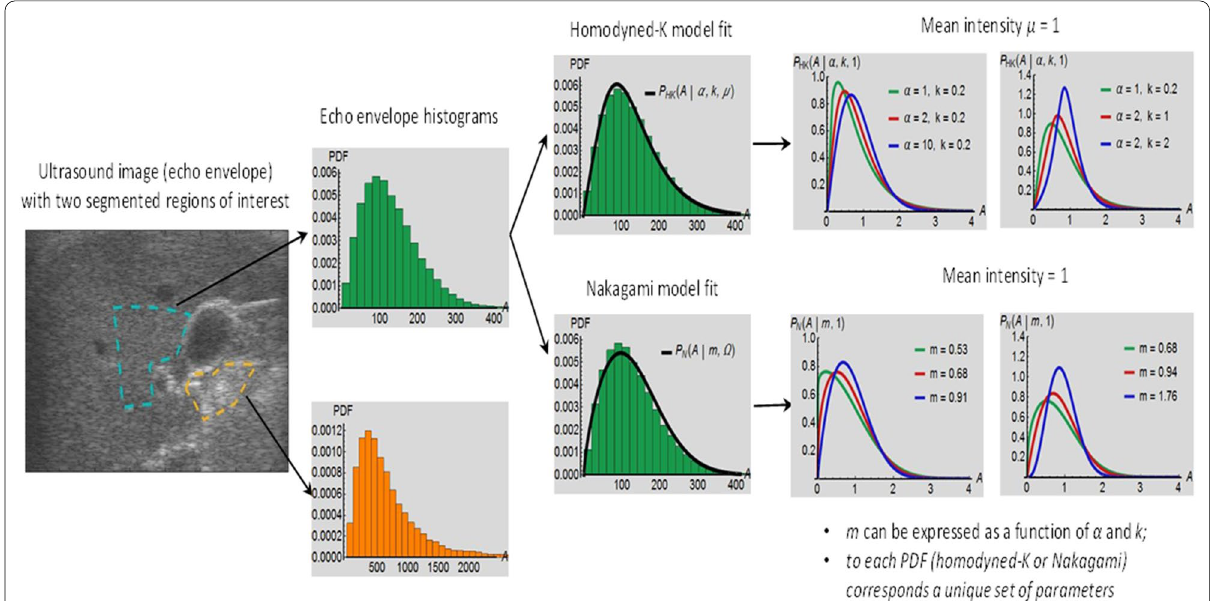
Fig. 16 Various statistics may be computed on the echo envelope data within a region of interest. Prior to modeling with a probability density function (PDF), a histogram of the echo magnitude is computed within a specified region of interest. Two models with meaningful parameters can be used to fit the data: (1) the homodyned- K distribution (HDK), which is a general model with one scale parameter (the mean intensity μ ) and two shape parameters ( α and k ); and (2) the Nakagami distribution, which is an approximate simpler model with one scale parameter (Ω) and a single shape parameter ( m ). As illustrated, changing the shape parameter(s) allow(s) modeling different forms of the image histogram corresponding to different backscatter tissue properties. P HK is the PDF of the fit with the HDK model; and P N is the PDF of the fit with the Nakagami model